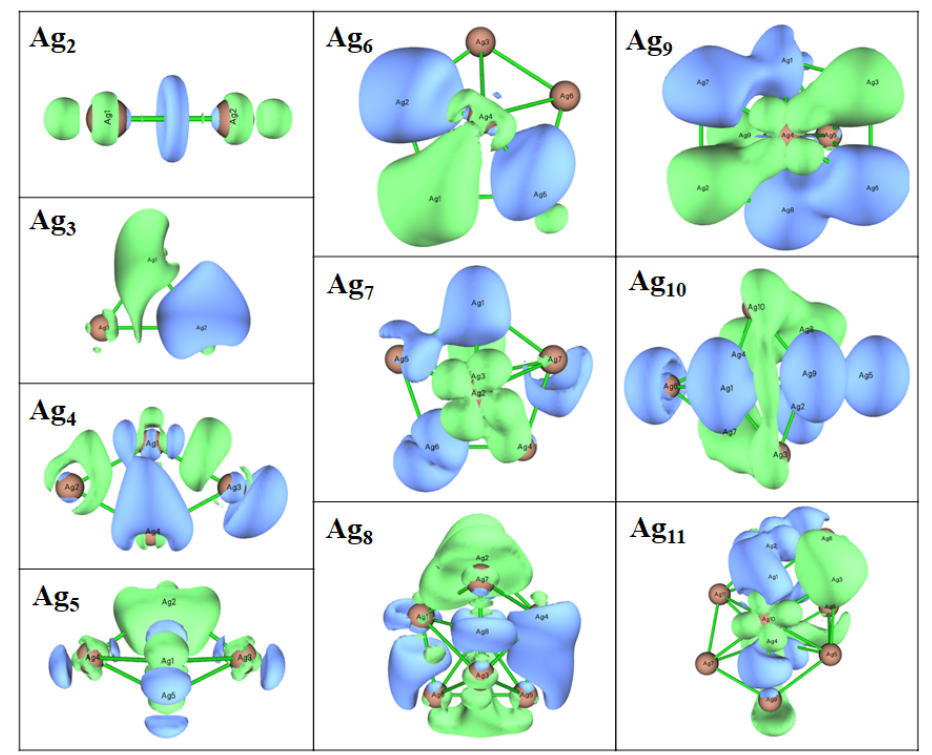
Figure 9. The dual descriptor ( ∆ f ( (cid:126) r ) ) of the most stable Ag n ( n = 2–11) clusters according to the DFT calculations. Green and blue regions correspond to positive and negative regions, respectively.